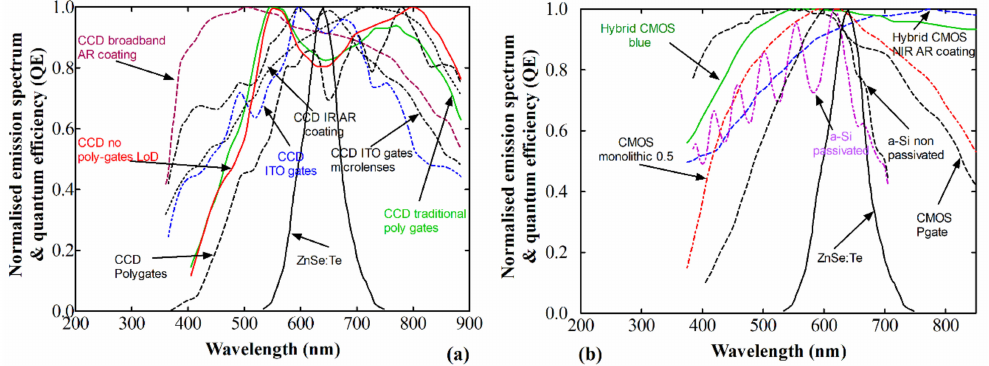
Figure 10. Normalized emission spectrum of ZnSe:Te in comparison with the spectral sensitivities of various sensors: ( a ) charge-coupled-devices; ( b ) complementary metal-oxide